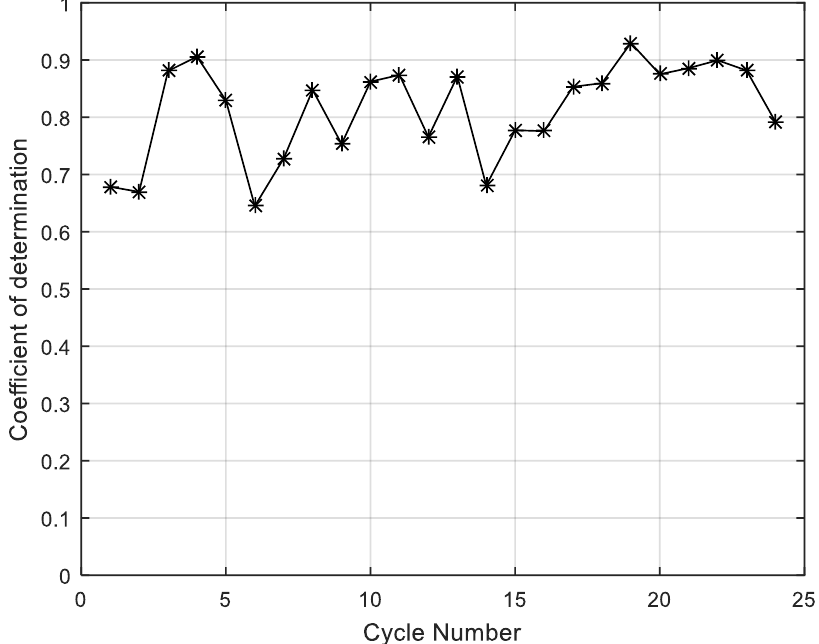
Figure 8. Coefficient of determination (𝑅 2 ) of the ML fit on different